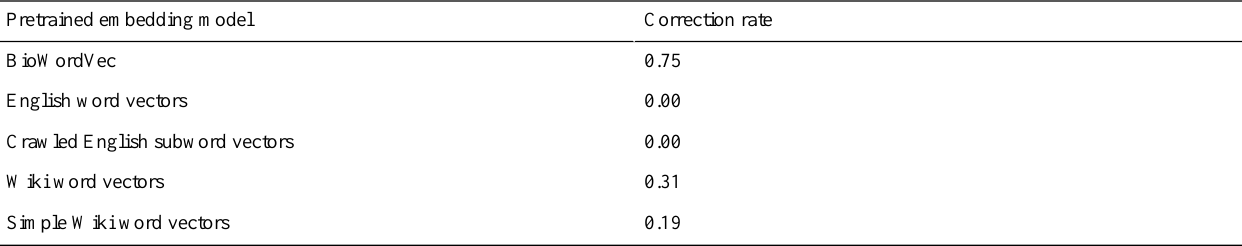
Table 3. Comparison of pretrained embedding.